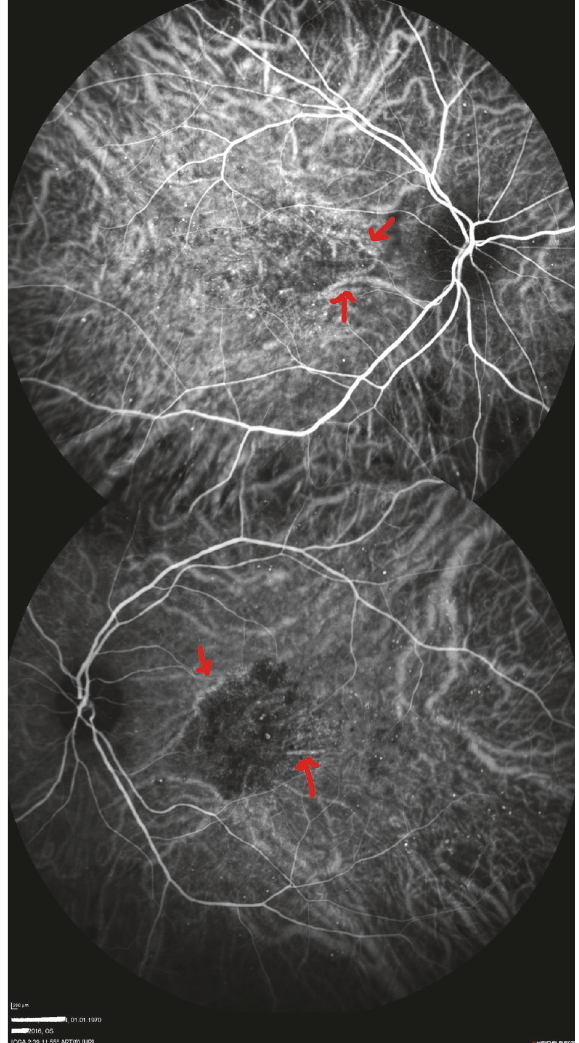
Figure 3: Indocyanine Green Angiography images (superior image is right eye and inferior image is left eye). Red arrows showchoroidal vascular